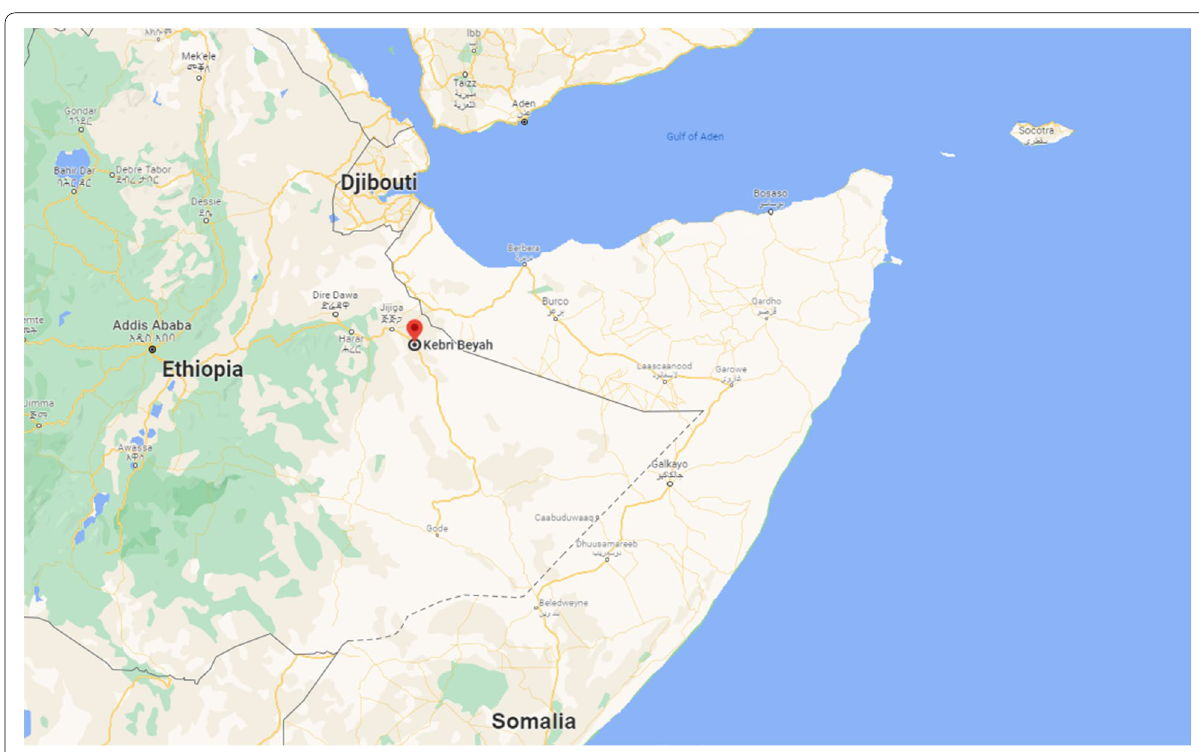
Fig. 1 Location of the Kebribeyah refugee